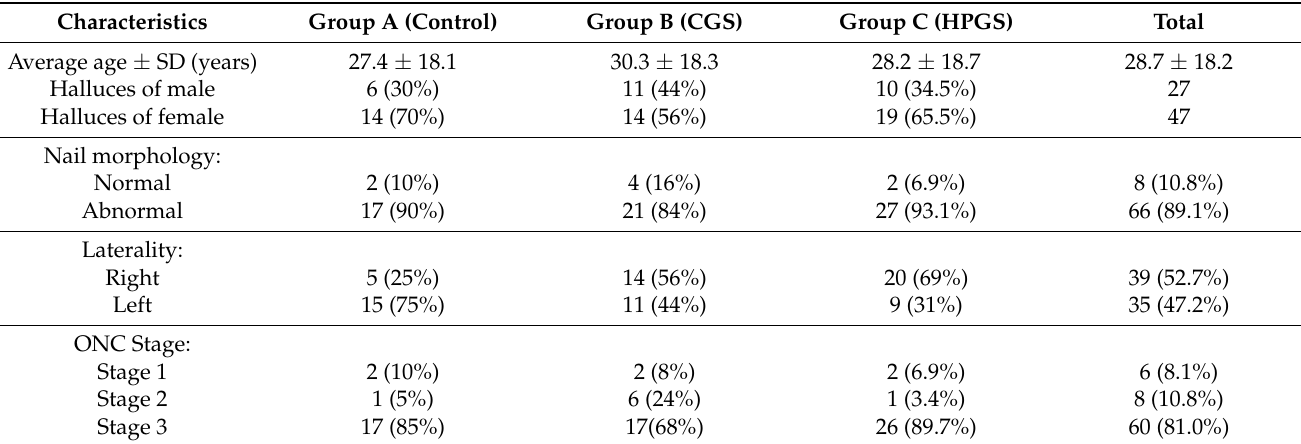
Table 1. Descriptive characteristics of the study